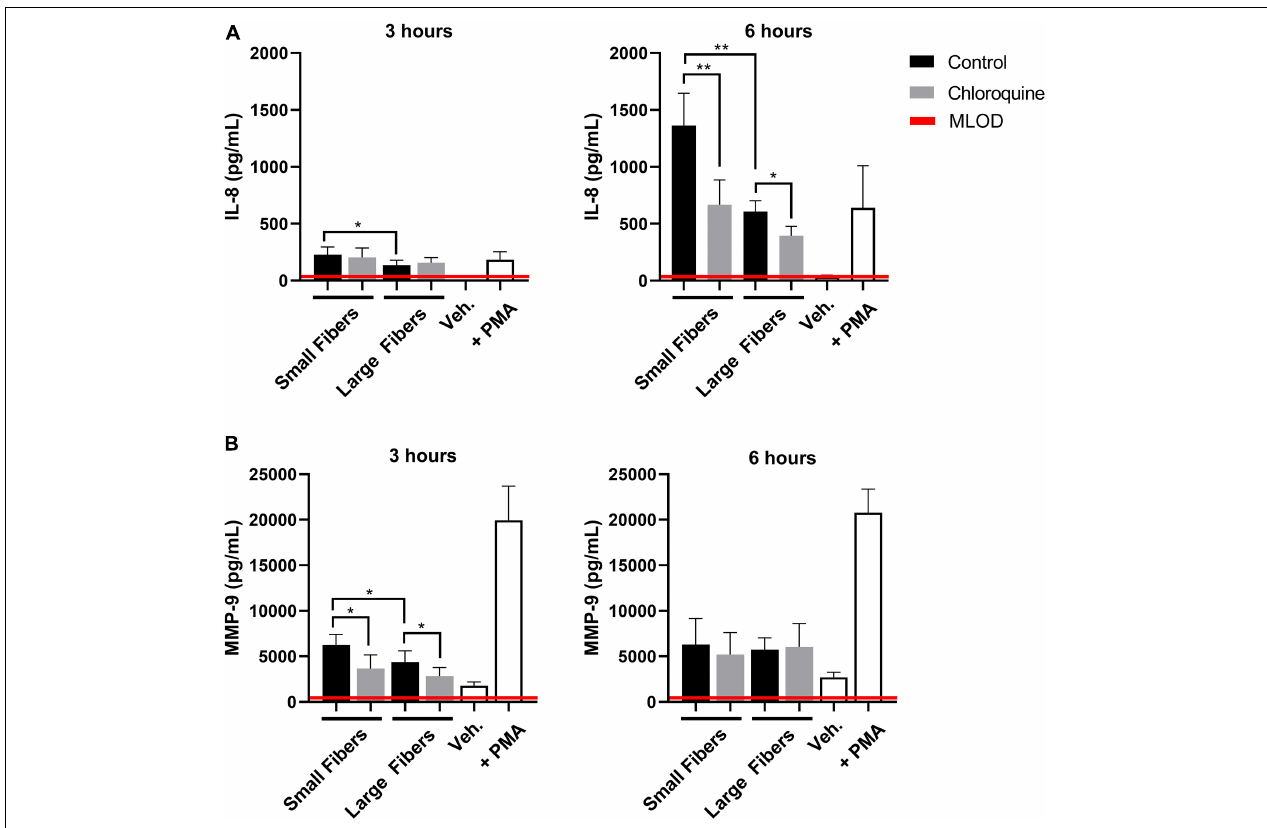
FIGURE 3 | Chloroquine-eluting biomaterials suppress inflammatory IL-8 and MMP-9 secretion from neutrophils. (A) IL-8 and (B) MMP-9 secretion at 3 h (left) and 6 h (right) after neutrophil seeding. Chloroquine elution down-regulated IL-8 secretion at both time points, whereas it only attenuates the acute secretion of MMP-9. The data ( n = 3) represent the mean ± standard deviation of three independent experiments with unique donors. * p < 0.05 and ** p < 0.0001 were determined using an analysis of variance (ANOVA) and Holm–Sidak multiple-comparisons test. Raw data are available in Supplementary Spreadsheet 1